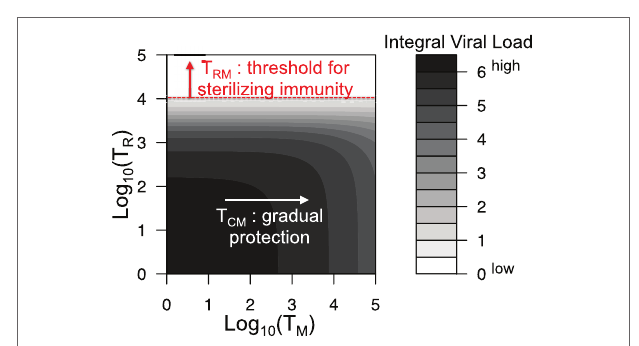
FIGURE 5 | Integral viral load dependence on the number of central memory and resident memory T cells at the onset of recall infection . All parameters are as in Figure 2 and Table 1